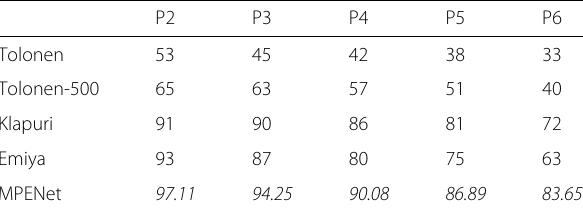
Table 5 F-measure (%) result with unknown polyphony level P2 P3 P4